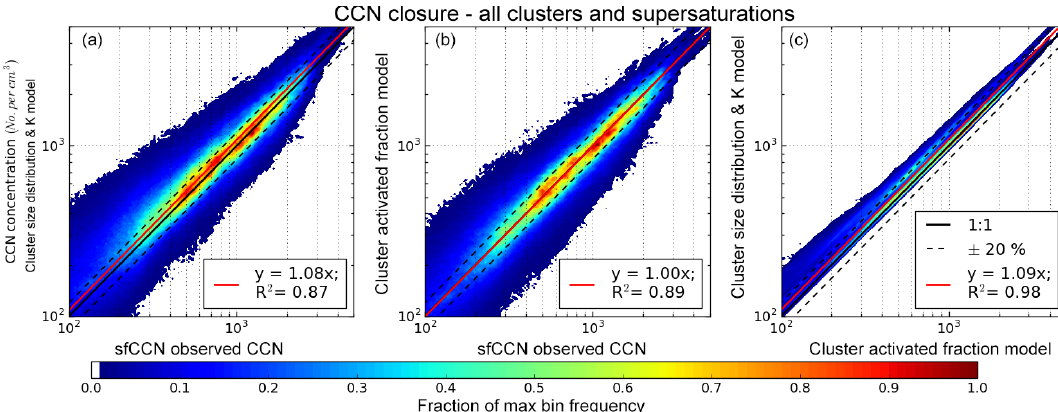
Figure 7. CCN closure comparing predicted and measured CCN number concentrations for (a) the predicted concentration based on the size distribution and κ reconstruction against observed concentrations, (b) the predicted concentration based on the best-fit activated fraction reconstruction against observed concentrations, and (c) the comparison between the two reconstruction methods. All cluster types and supersaturations across the full range of observed values are shown. Linear best-fit slope is shown in red with the associated R 2 values. One-to-one lines and lines at ± 20% are shown. Colors represent the data point density as a fraction of the maximum density in each